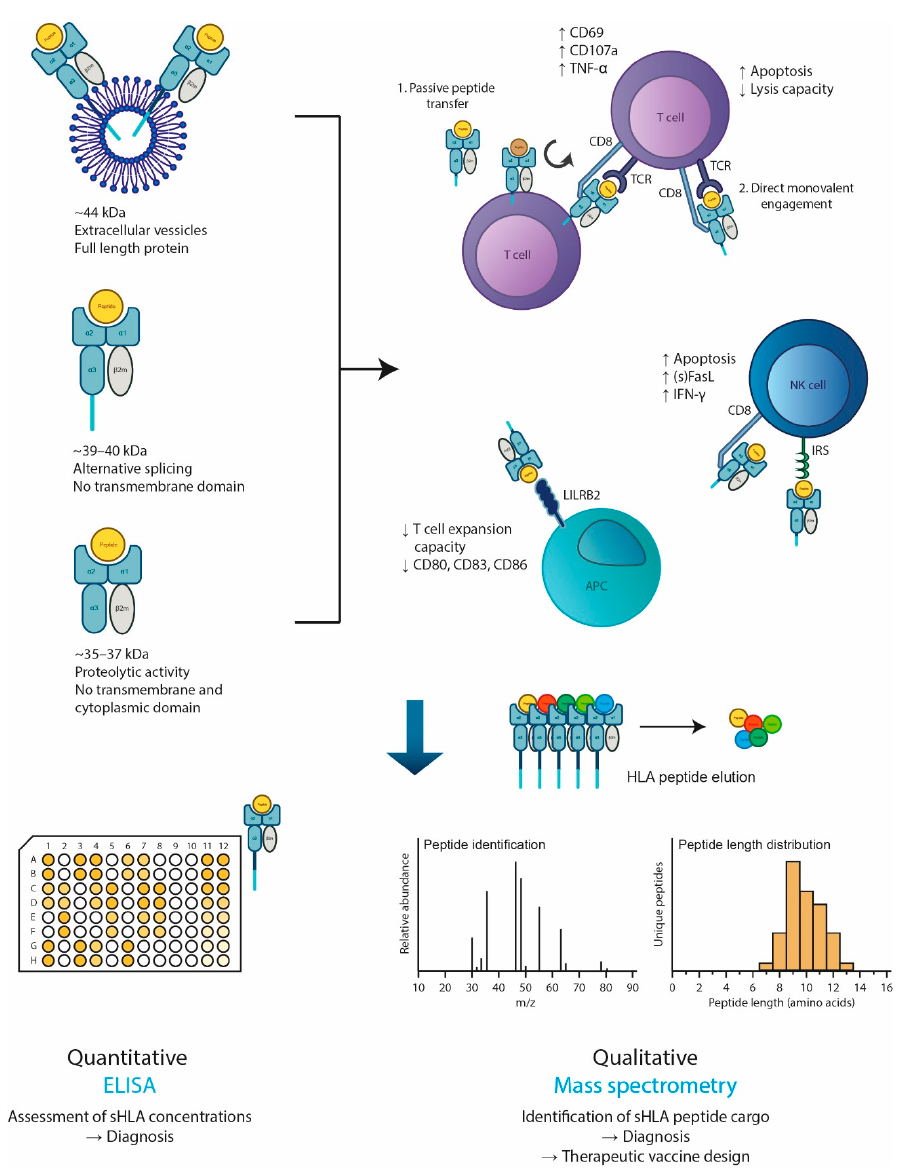
Figure 2. sHLA-I complexes: mechanisms of release, immunological e ff ects and analysis . sHLA-I complexes can be secreted into bodily fluids in three molecular forms depending on the mechanism of release. Once released, sHLA-I complexes may encounter T cells, NK cells or APCs and a ff ect their functioning through interaction with their respective receptors. For T cells, two mechanisms of activation have been postulated: passive peptide transfer or direct monovalent engagement. It is currently unknown whether each sHLA-I molecular form can a ff ect immune cells in a similar manner. Quantitative analysis of sHLA complexes is performed (mostly) by sandwich ELISA methods (chapter 2). Qualitative analysis, entailing the identification of peptides and their length, is performed by advanced mass spectrometry as described in chapter 4. See the main text for references to the studies providing evidence for the depicted